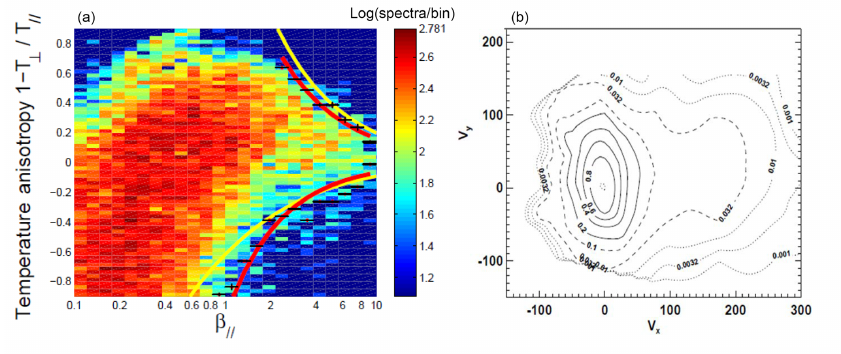
Figure 12. (a) Temperature anisotropy, A = 1 − T ⊥ /T (cid:107) , versus proton plasma beta β as derived from measured VDFs for the radial distance range R ≤ 0 . 4AU. The color bar indicates the logarithmically spaced bins of the number of occurrence. The yellow lines refer to the fire hose (with A > 0) and mirror/ion-cyclotron (with A < 0) instability. The red lines indicate the boundaries of the color-bin cloud. (b) A typical proton distribution function with anisotropic core and extended tail along the magnetic field. The anisotropy is A = − 0 . 4; the plasma beta is very high, β = 24; and the solar distance is 0.35AU. The figures were taken from Marsch et al.